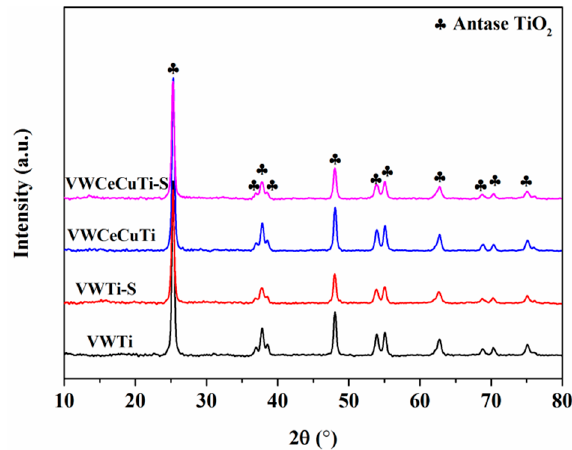
Figure 1. NO x conversion of ( a ) VWTi, ( b ) VWCeCuTi, ( c ) VWTi-S and ( d ) VWCeCuTi-S.